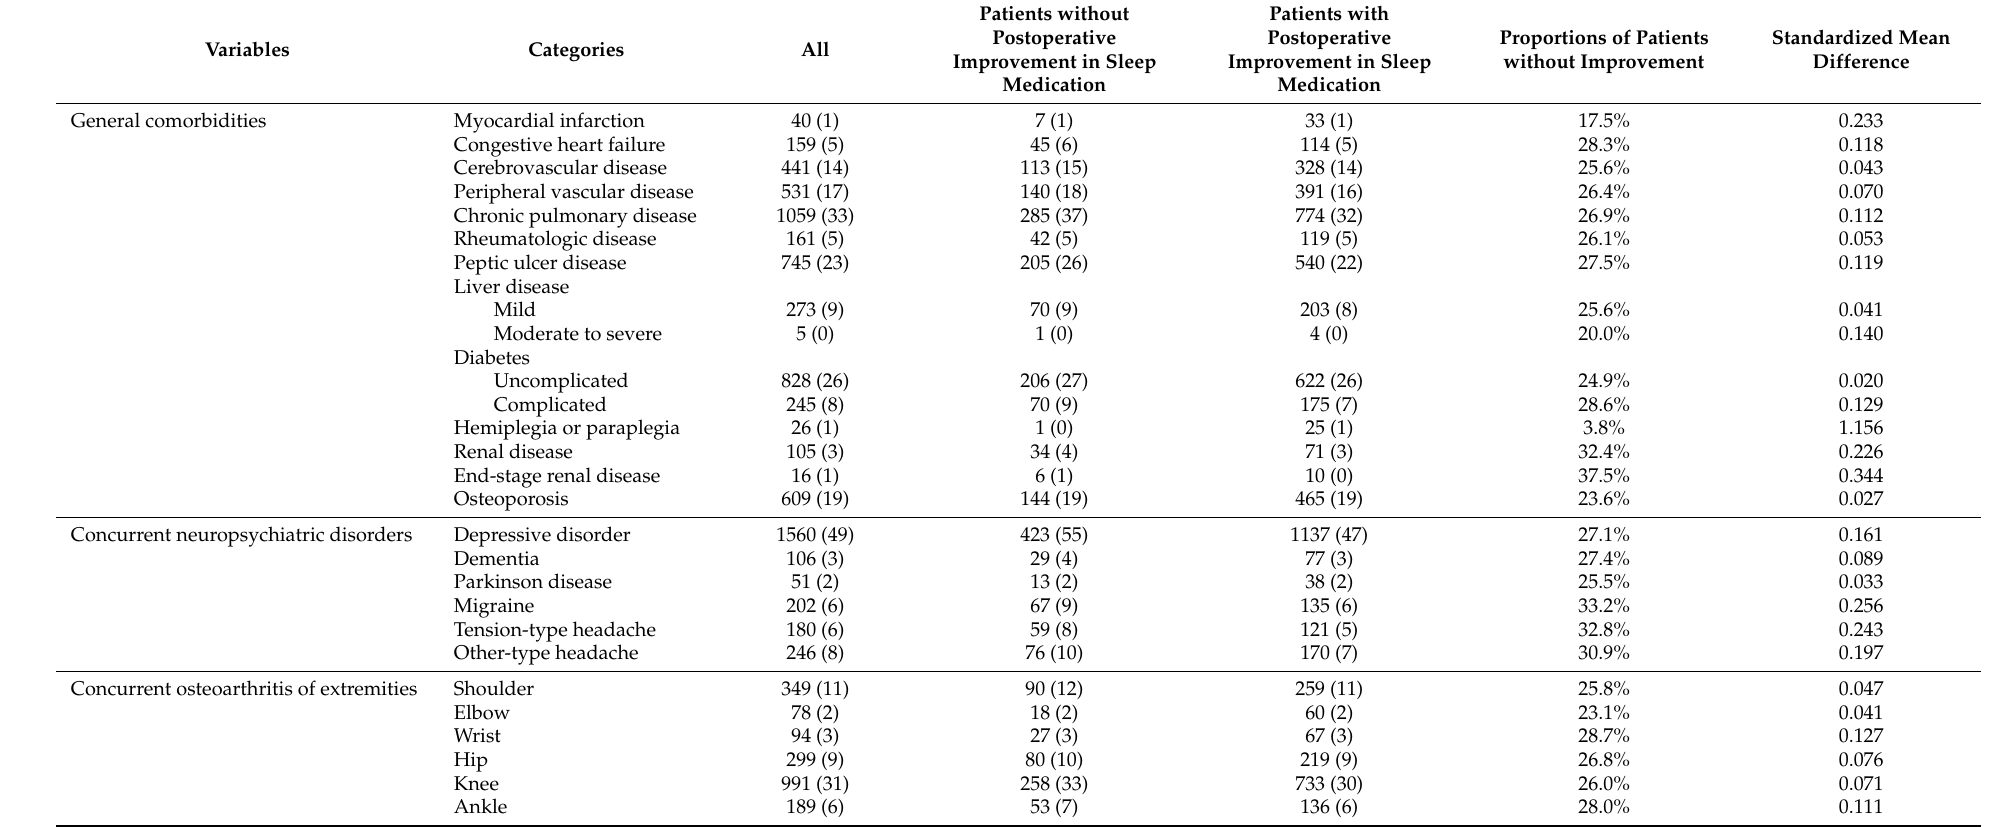
Table 2. Comorbidities of the cohort